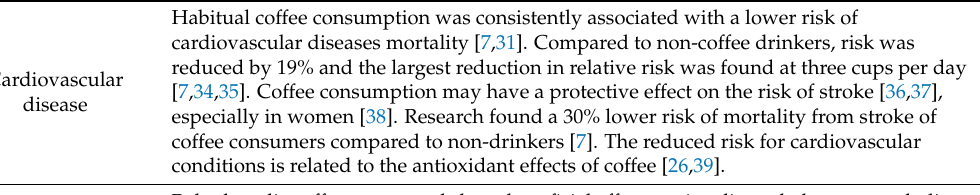
Table 1. Effects of coffee on single health